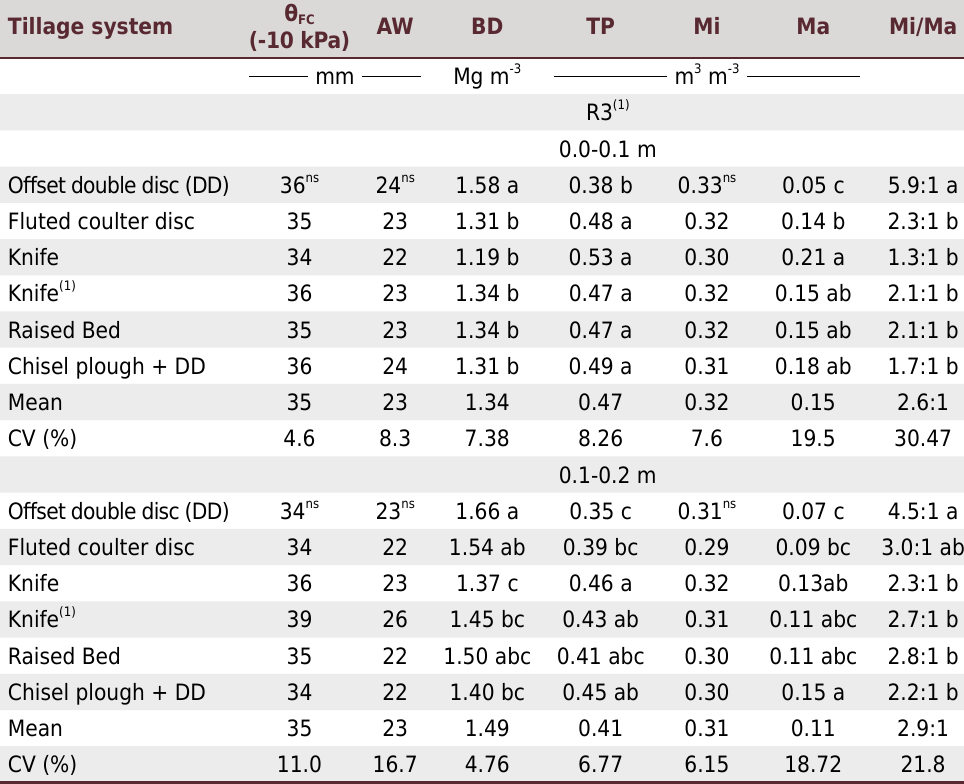
Table 4. Soil water retention at field capacity (θ FC ), available water (AW), bulk density (BD), total porosity (TP), microporosity (Mi), macroporosity (Ma), and Mi/Ma ratio in the treatments at different soil depths. Santa Maria, Brazil. Experiment 1 in the 2014/15 crop season Tillage system